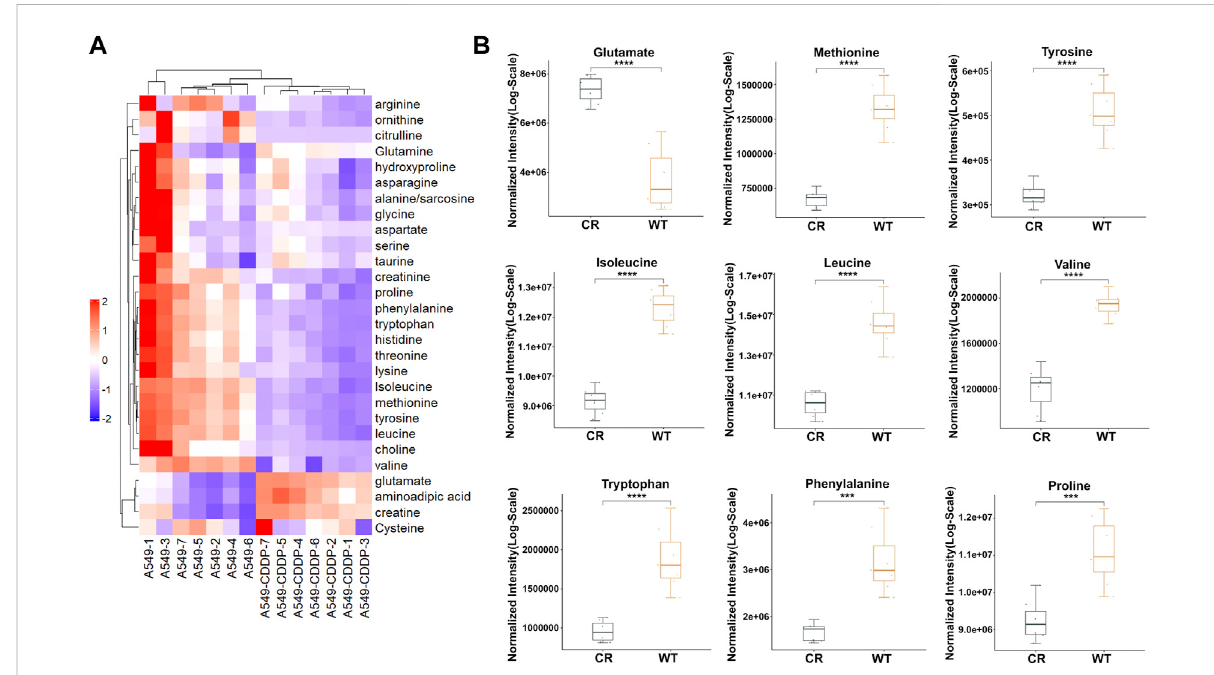
FIGURE 1 The amino acid targeted metabolic pro fi ling reveals signi fi cantly altered metabolites in A549 cells with cisplatin resistance. (A) Heatmap of differential amino acids quanti fi ed in A549 and A549/CDDP cells. (B) Boxplots of the relative concentration distribution of representative differential amino acids, including glutamate, methionine, tyrosine, isoleucine, leucine, valine, tryptophan, phenylalanine, and proline. * p < 0.05, ** p < 0.01, *** p < 0.001, **** p <